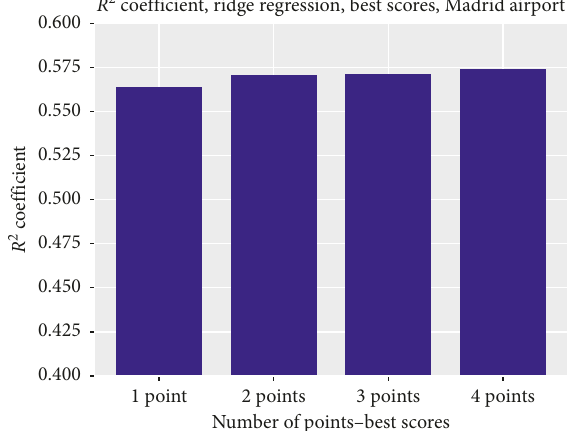
Figure 10: Quality of the ridge regression for different number of points (wind